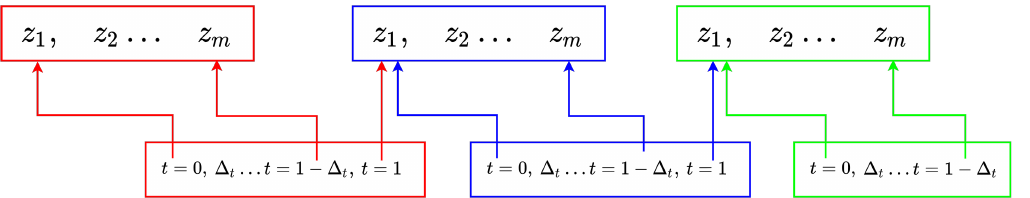
Figure 6. Scheme showing the signal partition scheme followed to allow Hermite splines’